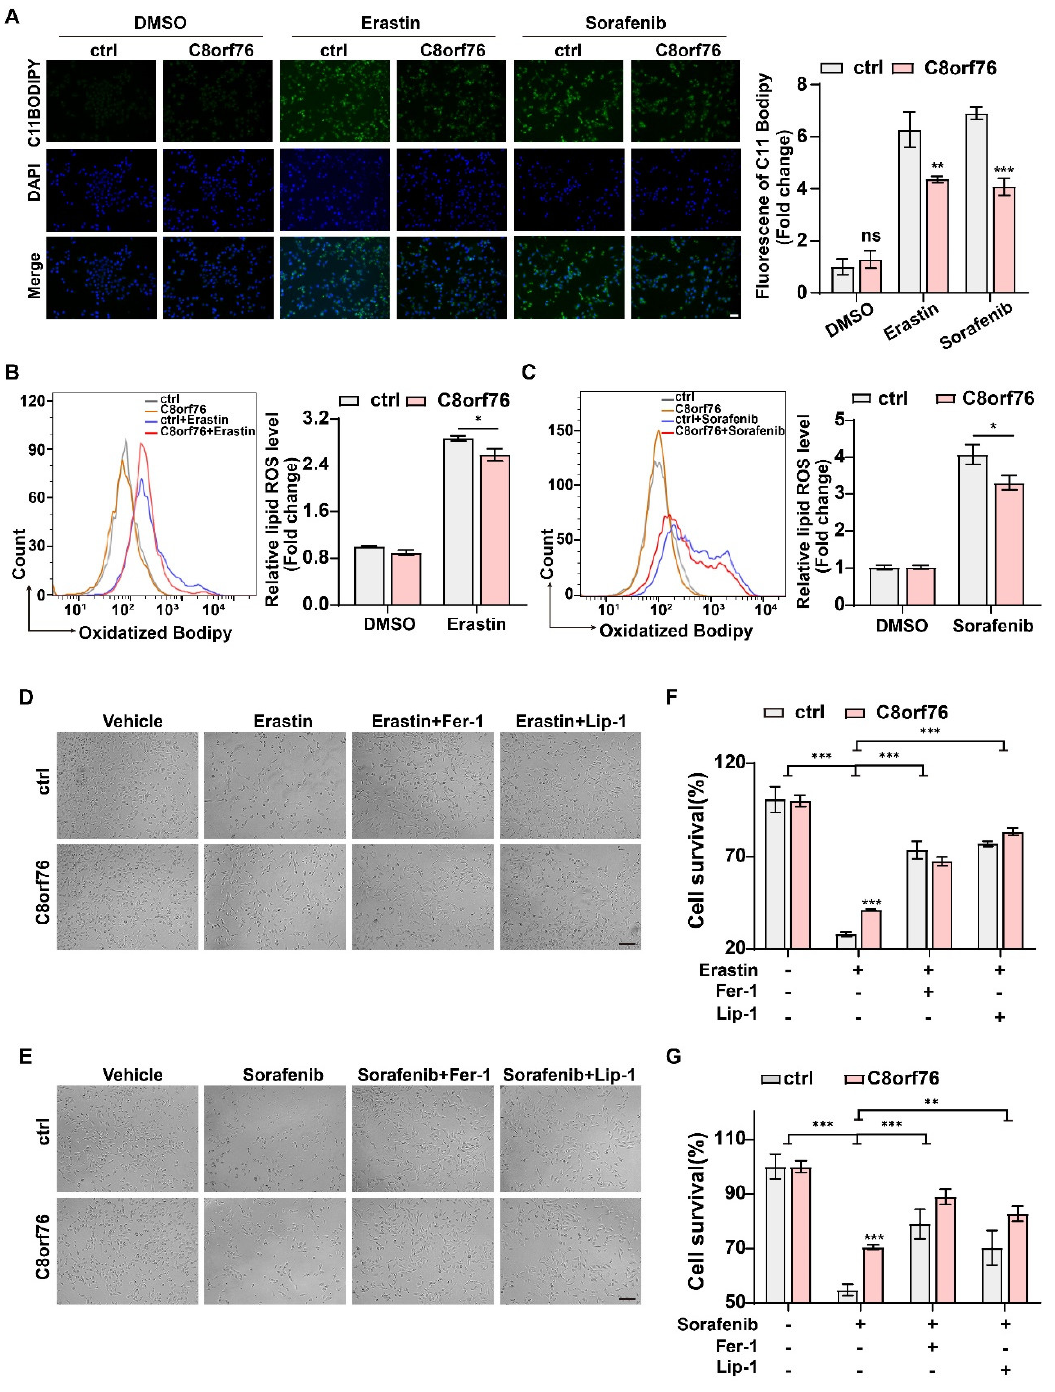
Figure 6. Erastin and sorafenib-induced accumulation of lipid ROS and ferroptois in C8orf76OE cells. Lipid ROS production followed by erastin and sorafenib was viewed by an inverted fluorescent microscope ( A ) and detected by flow cytometry ( B , C ). Scale bars represent 50 μm. ( D , E ) HCC cells were visualized at the treatment of 7.5 μM erastin or 7.5 μM sorafenib with or without ferroptosis inhibitors (Fer−1, 1 μM; Lip−1, 0.4 μM). Scale bars represent 200 μm. ( F , G ) MTS assay was performed to monitor the cell viability induced by erastin (7.5 μM) or sorafenib (7.5 μM) combined with or without ferroptosis inhibitors (Fer−1, 1 μM; Lip−1, 0.4 μM). Data were presented as mean +SD. * p < 0.05; ** p < 0.01; *** p < 0.001; ns, not significant. Fer−1, ferrostatin−1; Lip−1, liproxstatin−1.